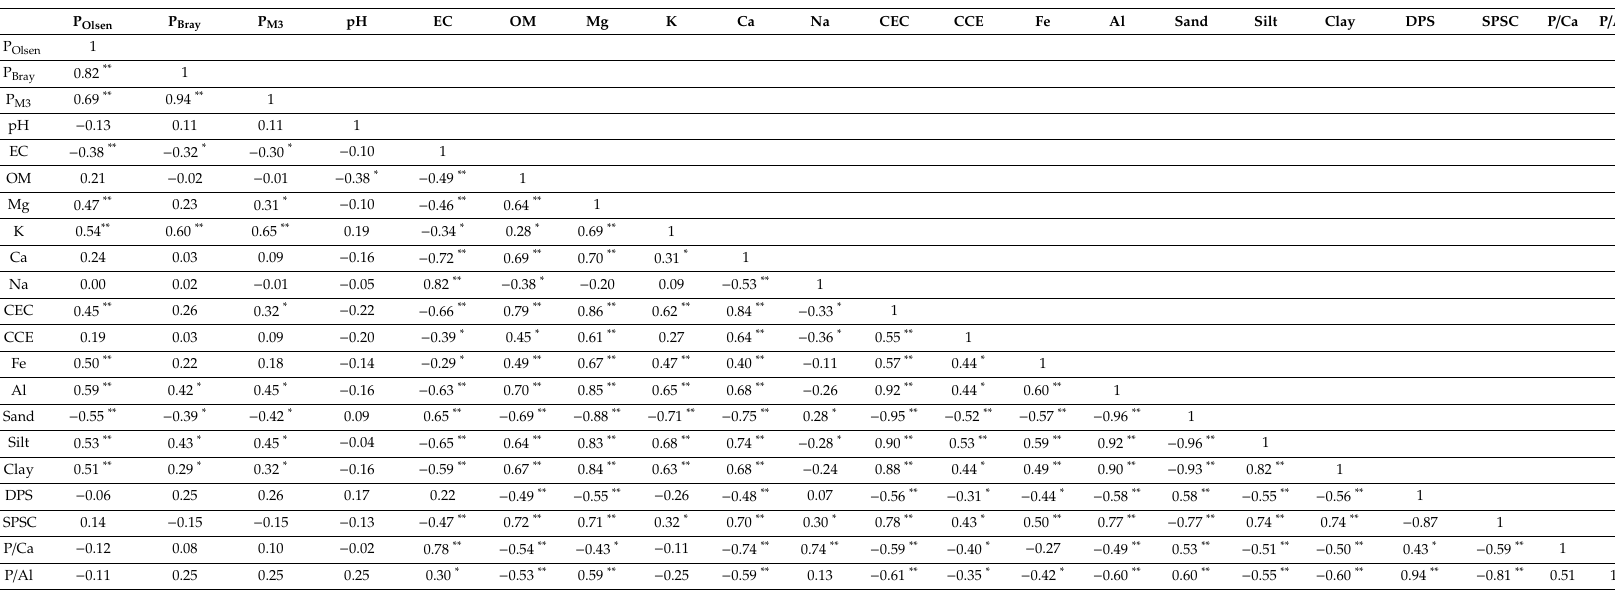
Table 4. The correlation between physio-chemical soil properties, soil P tests and potential environmental indices of P loss from